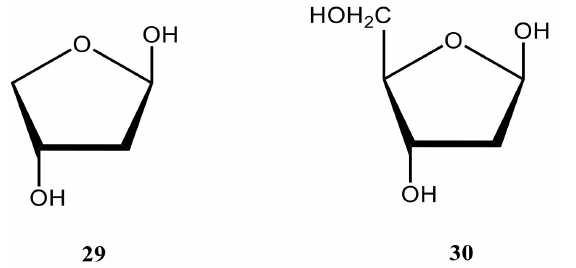
Figure 21. The structural formulas of 2-deoxy- β -D-erythro-pentofuranose ( 30 ) and its model form ( 29 ).